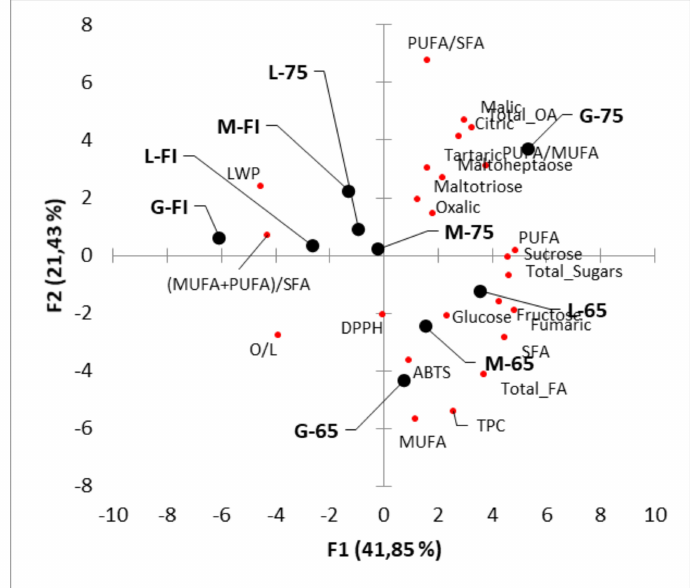
Figure 1. Principal component analysis (PCA) score biplot showing relationships among leaf water potential (LWP) and quality parameters. Black dots indicate samples. O / L, oleic / linoleic ratio; MUFA, monounsaturated fatty acid; PUFA, polyunsaturated fatty acid; SFA, saturated fatty acid; Total_FA, total fatty acids; TPC, total phenolic